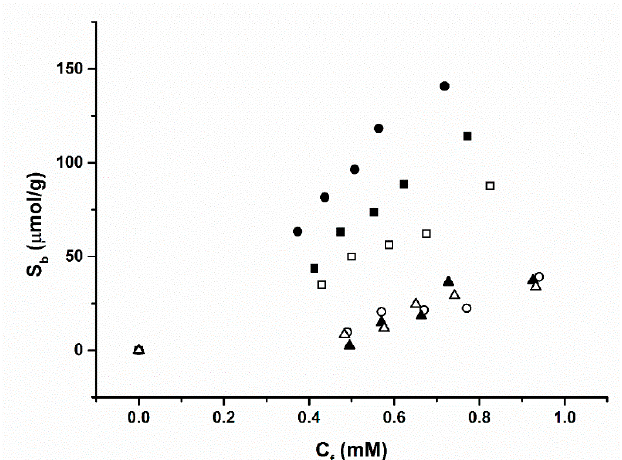
Figure 2. Binding isotherms of the polymerised MIP/NIPs upon exposure to amoxicillin solutions in Phosphate Buffered Saline (PBS). MIP 1 ( filled squares ) and NIP 1 ( hollow squares ), MIP 2 ( filled circles ) and NIP 2 ( hollow circles ) and MIP 3 ( filled triangles ) and NIP 3 ( hollow triangles ).